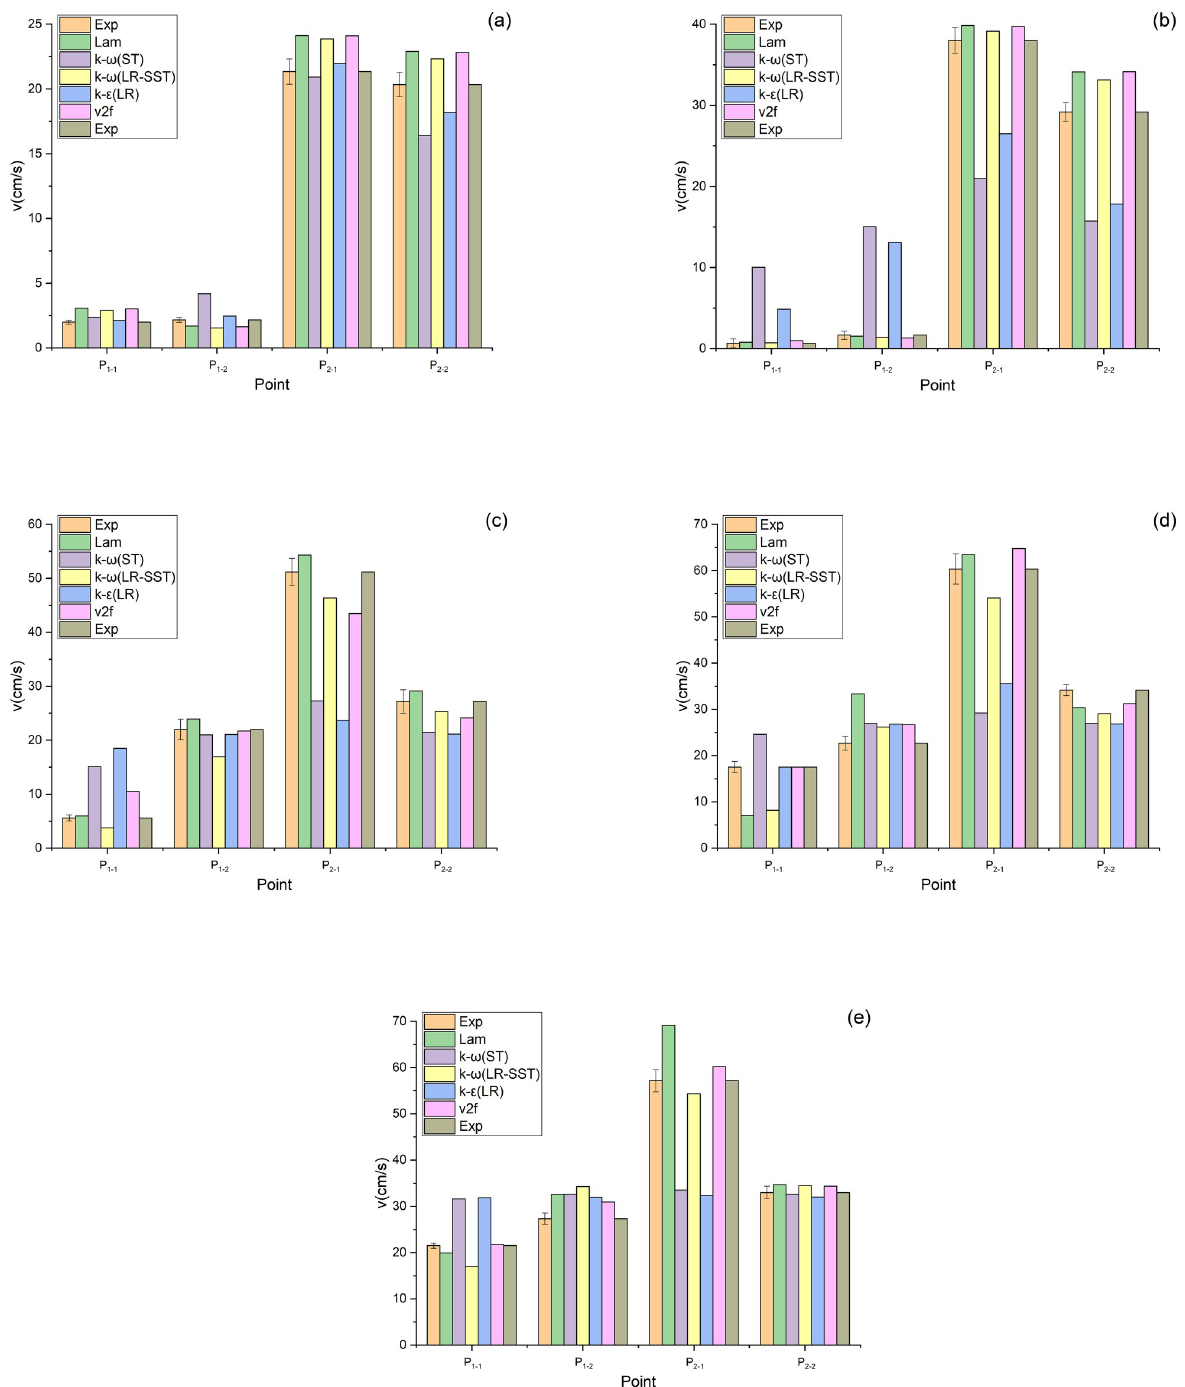
Fig 11. Air velocities of the U-shaped filters at measuring points under different CFD models (a) α = 0.71, (b) α = 1.43, (c) α = 2.14, (d) α = 2.86, (e) α = 3.57.